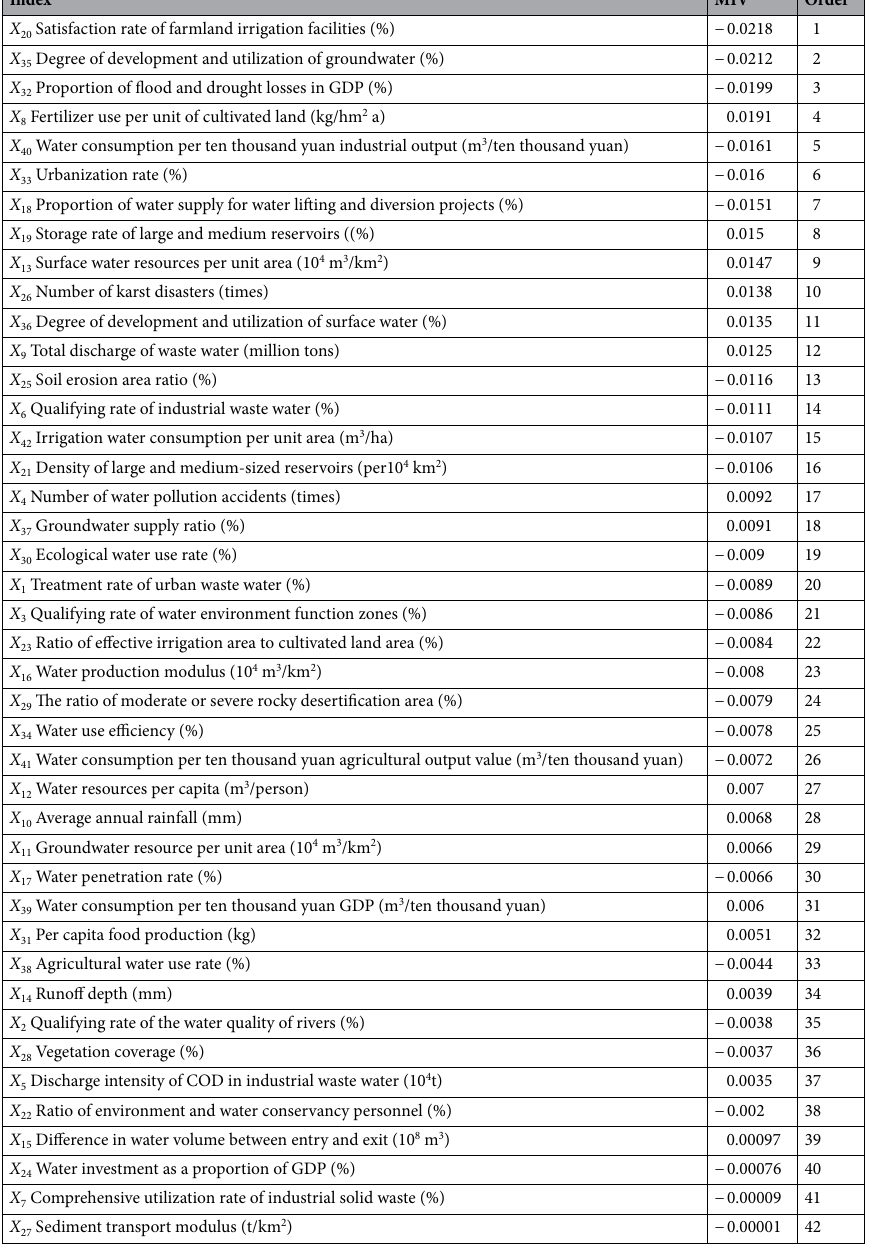
negative number indicates the